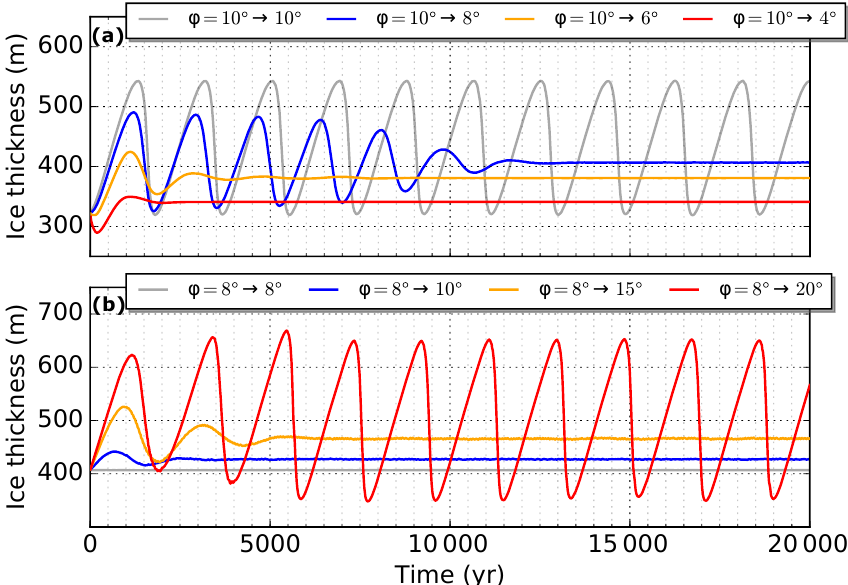
Figure 8. Time series of ice thickness H for (a) an ice sheet in oscillatory equilibrium ( φ = 10 ◦ ) which is perturbed by a decrease of φ and (b) an ice sheet in stable equilibrium ( φ = 8 ◦ ) which is perturbed by an increase of φ . In order to bring the stable ice sheet into the regime of maintained surging φ has to be increased substantially ( φ = 8 ◦ → 20 ◦ ), whereas it has to be lowered only slightly ( φ = 10 ◦ → 8 ◦ ) to stabilize the surging ice